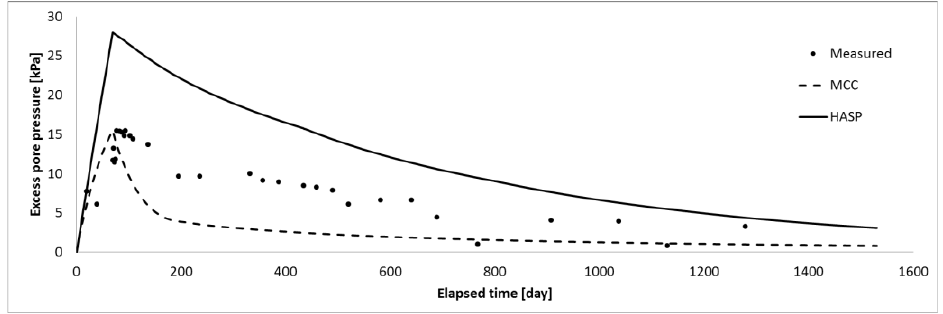
Figure 19. Comparison of excess pore pressure-time curves for Embankment B — Point PC2-3 (7.0 m below the surface).